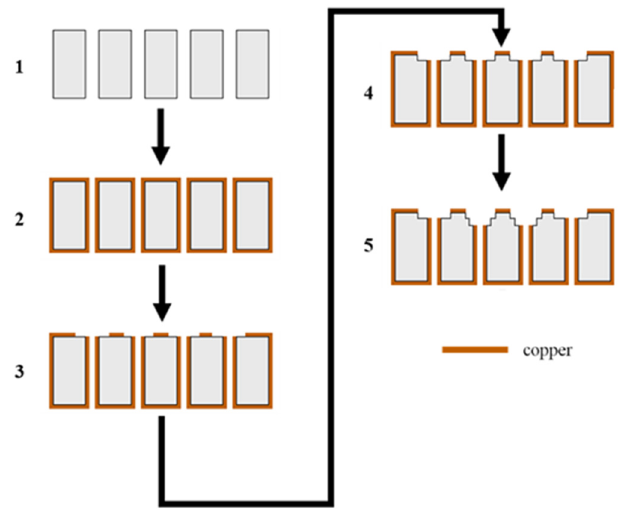
Figure 13. The final manufacturing process of the microwave dielectric ceramic filter.